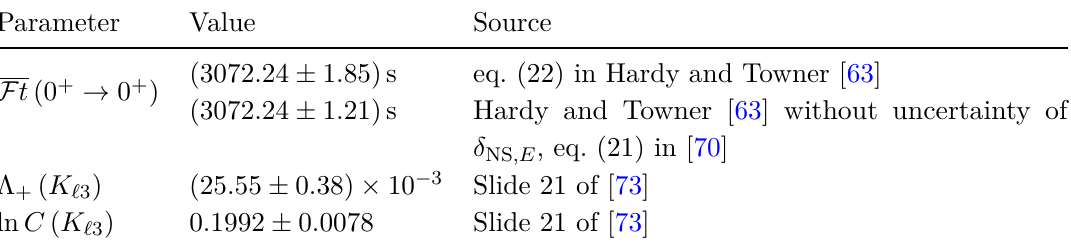
Table 3 . Updated experimental inputs for the CKM determinations used in this